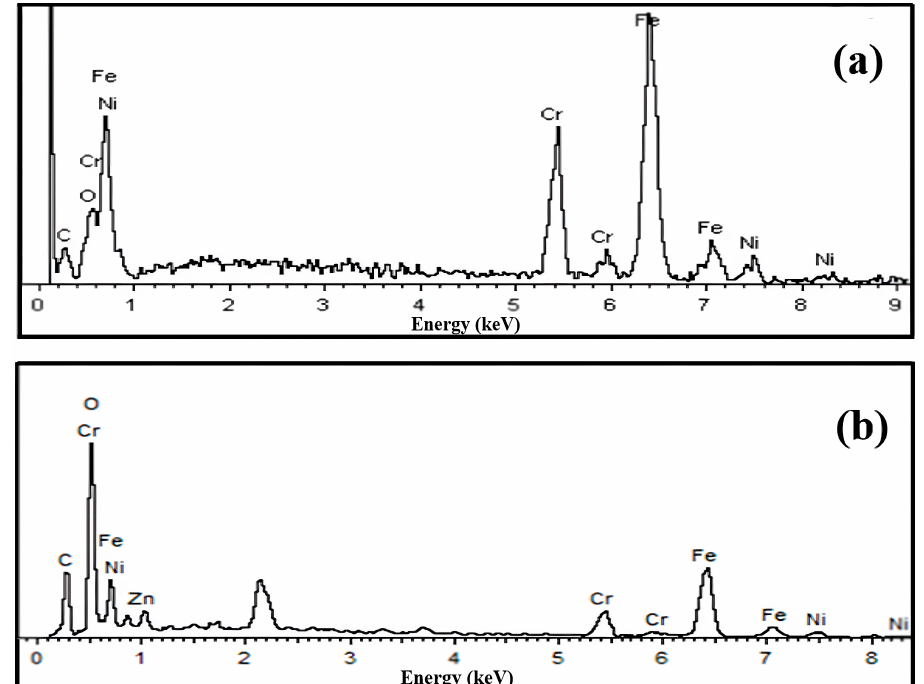
Figure 4. ( a ) FT ‐ IR spectra of powder COF ‐ TpBD; ( b ) TGA curve of powder COF ‐ TpBD; ( c ) N 2 ad ‐ sorption–desorption isotherms of the etched stainless steel sheet; ( d ) pore size distribution of the etched stainless steel sheet.